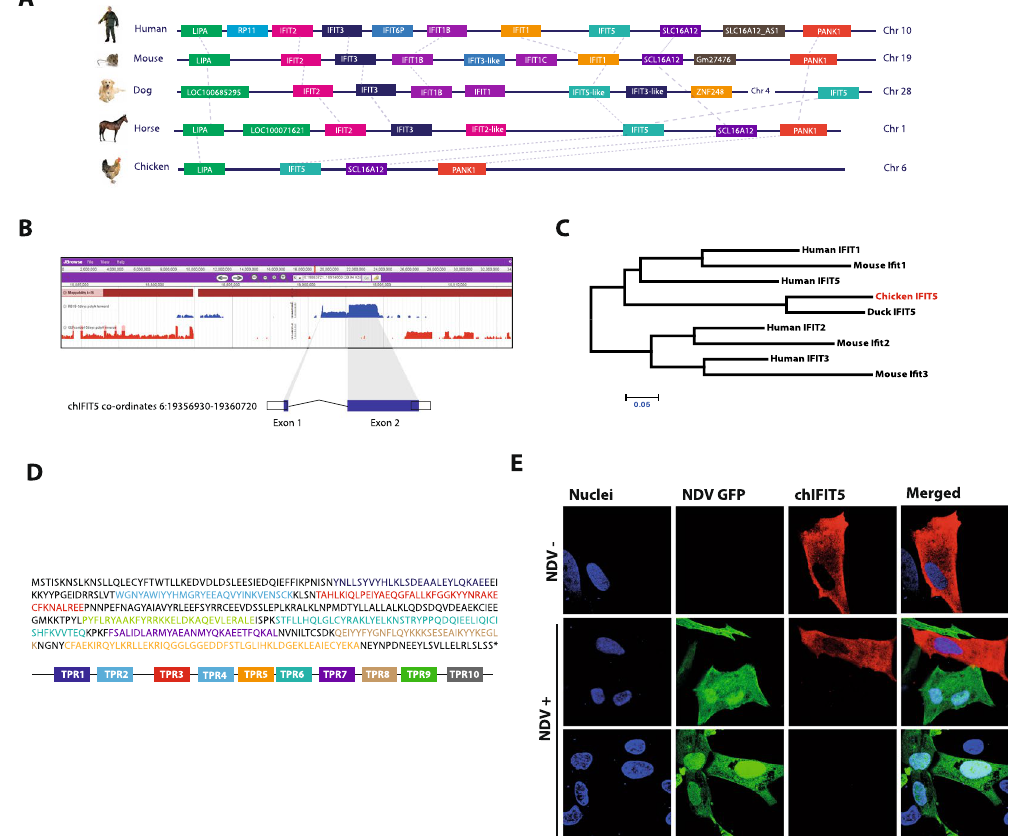
Figure 1. Genomic architecture along with relative loci around IFIT genes in human, mouse, dog, horse and chicken, and gene annotation in chicken. ( A ) The IFIT locus in compared species is flanked upstream with LIPA gene and downstream with PANK1 gene. Direct syntenic analysis identified a single IFIT5 gene in chicken compared to four in other species aslong with other pseudogenes. ( B ) Transcriptomics profiling of chicken primary fibroblasts which were mock-infected or infected with RB1B strain of MDV. Blue bar represents the transcript in the current chicken genome assembly whereas the red bar represents the mappability of the transcript to the chicken genome. A final transcript from MDV-infected data and gene characterization is shown at the bottom. ( C ) Phylogenetic analysis of IFIT genes in different species. Based on the clustering patterns and sequence homologies, the single identified gene clustered closer to IFIT5 of duck and human. ( D ) Putative tetratricopeptide repeats (TPR) showing characteristic features of IFIT proteins. ( E ) Expression and subcellular distribution of chIFIT5 in chicken embryo fibroblasts. Chicken cells were transfected with 500 ng of mammalian expression vectors encoding V5-tagged chIFIT5 for 24 hours and were left untreated (NDV-) or were treated with 1 MOI of NDV-GFP (NDV + ) for another 24 hours before fixation, staining for nucleus (blue), chIFIT5 (red) and GFP marker